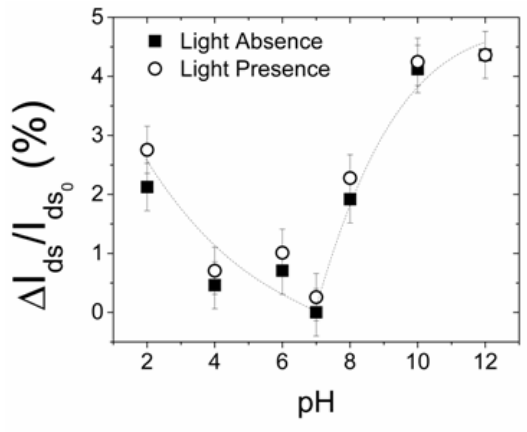
Fig. 4. Percent current variation (ΔI presence and in the absence of